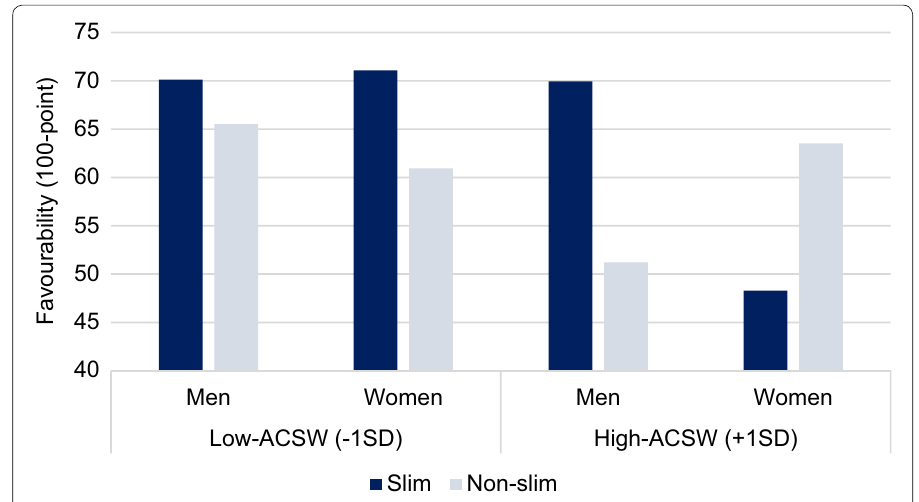
Fig. 2 A 3-way interaction of the target woman’s slimness condition, participants’ gender and ACSW on favorability perception towards the target woman. At the low-ACSW value, women showed higher favorability toward a slim (vs. non-slim) woman while men showed no difference. At the high-ACSW value, men favored slim (vs. non-slim) woman, while women favored non-slim (vs. slim)